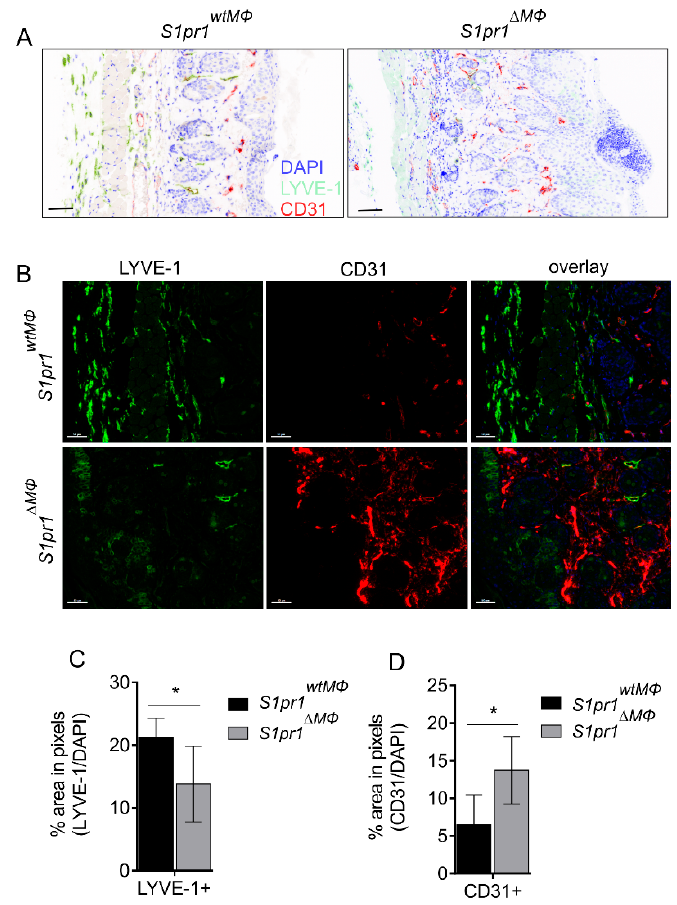
Figure 4. Reciprocal regulation of blood and lymph vessels in psoriatic S1pr1 ∆ M Φ . ( A – D ) S1pr1 wtM Φ (black bar) and S1pr1 ∆ M Φ (grey bar) mice were treated daily with 62.5 mg IMQ on the back skin for up to 5 days. ( A ) Histology images of skin sections from 5-day IMQ-treated mice (indicative of 7–9 animals each) stained with anti-LYVE-1 (green), anti-CD31 (red) and DAPI (blue). Scale bars represent 100 µ m. ( B ) PhenOptics images of skin sections from 5-day IMQ-treated mice (indicative of 7–9 animals each) stained with anti-LYVE-1 (green), anti-CD31 (red) and DAPI (blue). Scale bars represent 50 µ m. ( C ) The graph shows quantification of the mean LYVE-1 signal in the whole skin presented as % area in green pixels normalized to blue pixels of nuclear counterstain DAPI. Data are means ± SD, n = 6 individual animals. ( D ) The graph shows quantification of the mean CD31 signal in whole skin presented as % area in red pixels normalized to blue pixels of nuclear counterstain DAPI. Data are means ± SD, n = 4 individual animals. * p < 0.05; p values were calculated using two-tailed multiple t -test with Holm–Š í d á k correction